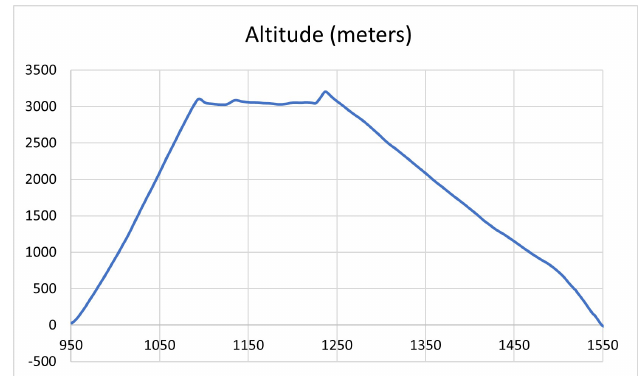
Figure 3. Height: Validation Flight.